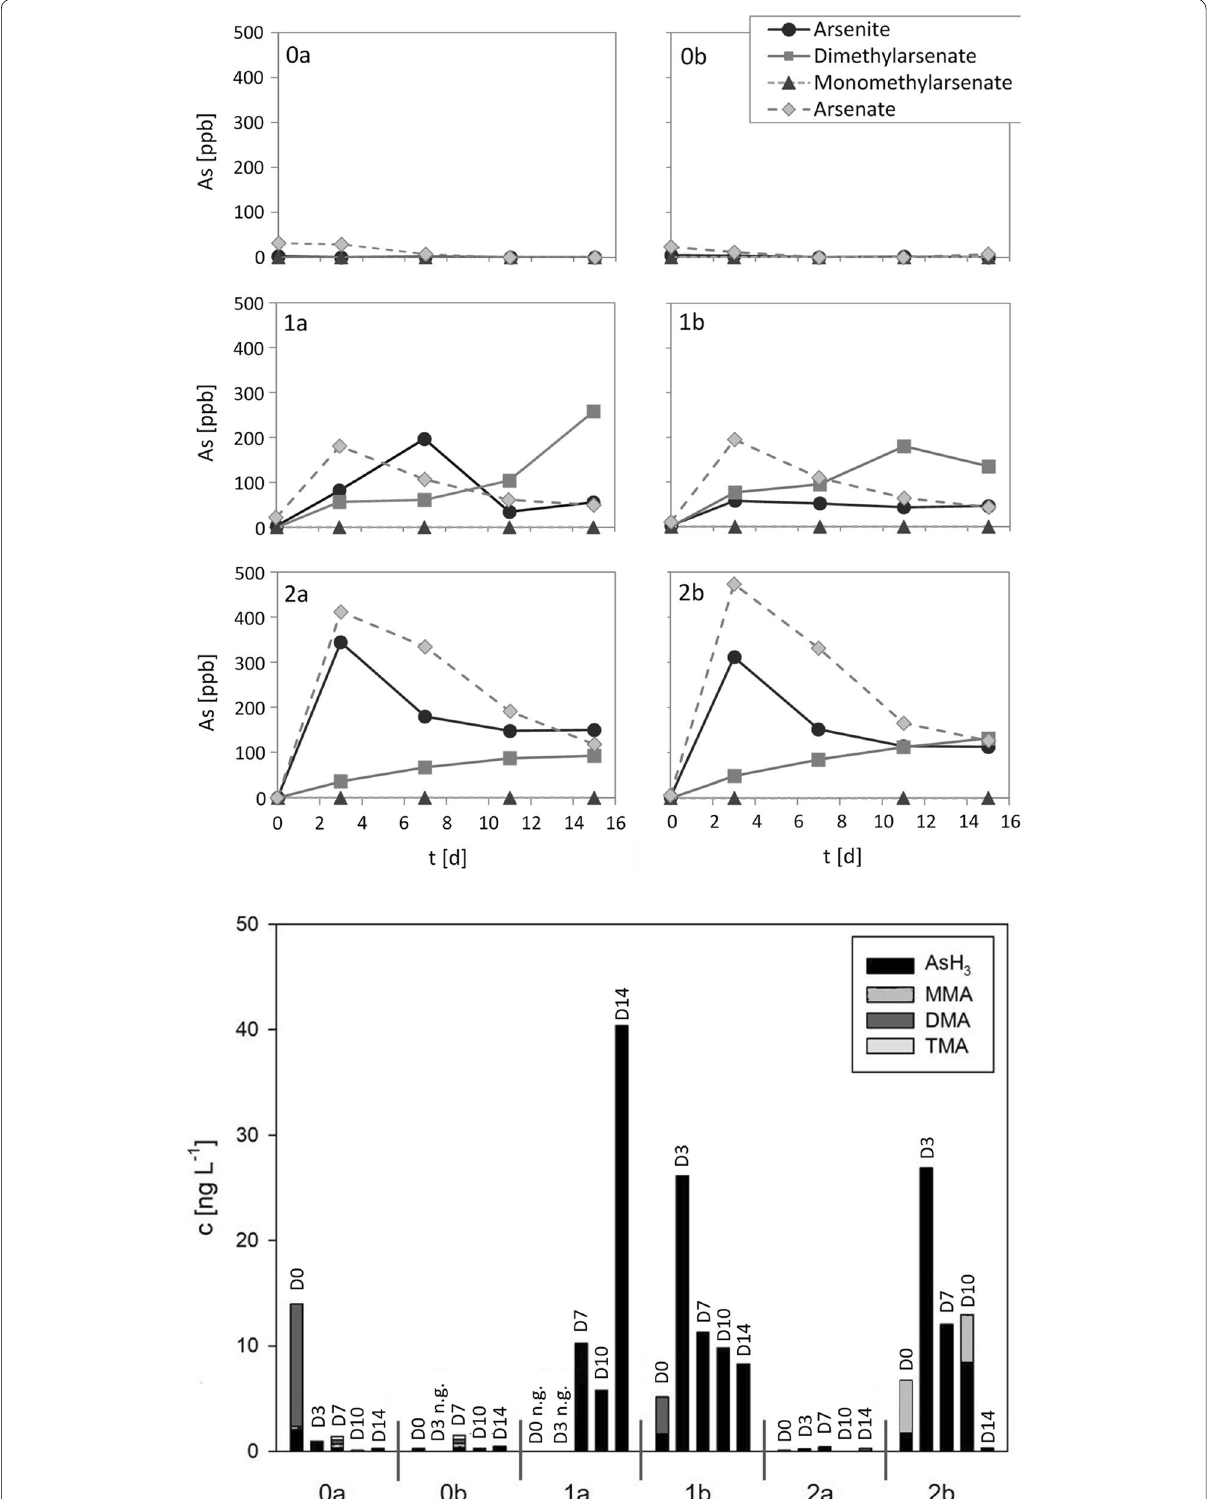
Fig. 6 As species in the liquid (top) and gas phases (bottom) of the satellites to the sewage sludge digester (plant #14). Satellites 0a and b (controls) contained no additional As, satellites 1a and b contained 30 µM (2.25 mg L − 1 ) of additional As, and satellites 2a and b 60 mM (4.5 mg L − 1 ) of additional As. As was added as NaAsO 2 . Concentrations of As species in the liquid phase are given as